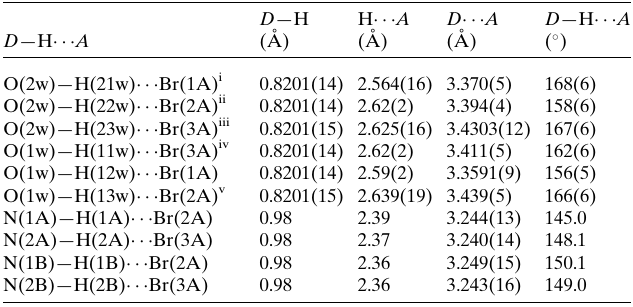
Table 2 Hydrogen-bond contacts in (cid:2) -[dabcoH 2 ] 2+ [H 3 O] + Br (cid:2) 3 , with the donor– acceptor ( D (cid:3)(cid:3)(cid:3) A ) distances shorter than the sum of their van der Waals radii (Bondi, 1964) and angle D —H (cid:3)(cid:3)(cid:3) A larger than 110 (cid:5) . D —H (cid:3)(cid:3)(cid:3)